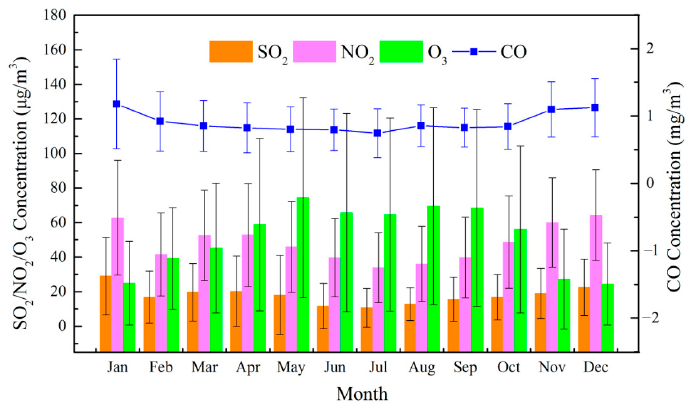
Figure 8. Monthly variations of O 3 , SO 2 , NO 2 , and CO in Hangzhou City for the years 2014–2016.